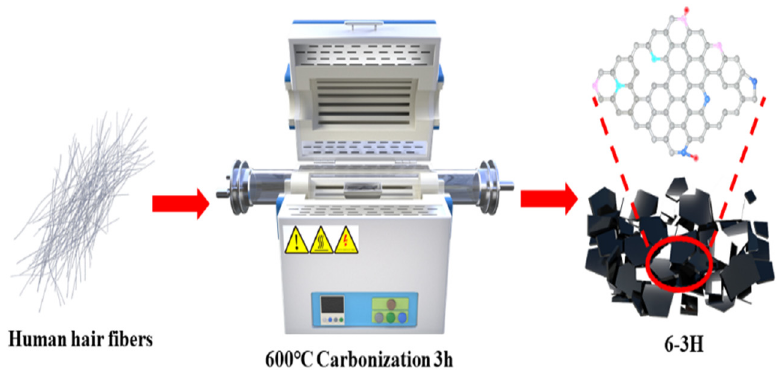
Figure 1. Schematic diagram for the preparation of hair-based carbon sheets.